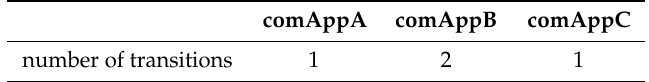
Table 4. Number of transitions of comAppA, comAppB and comAppC.